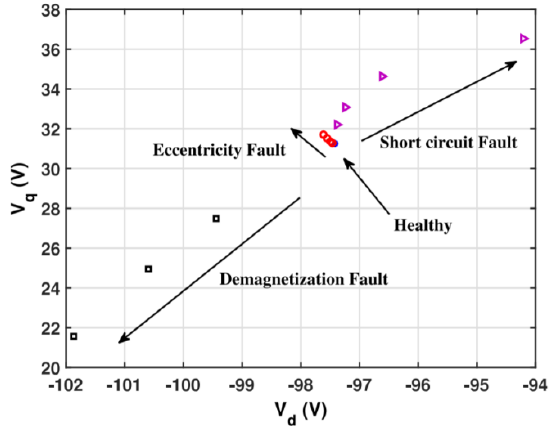
Figure 7. V d – V q plane for fault classification [57].